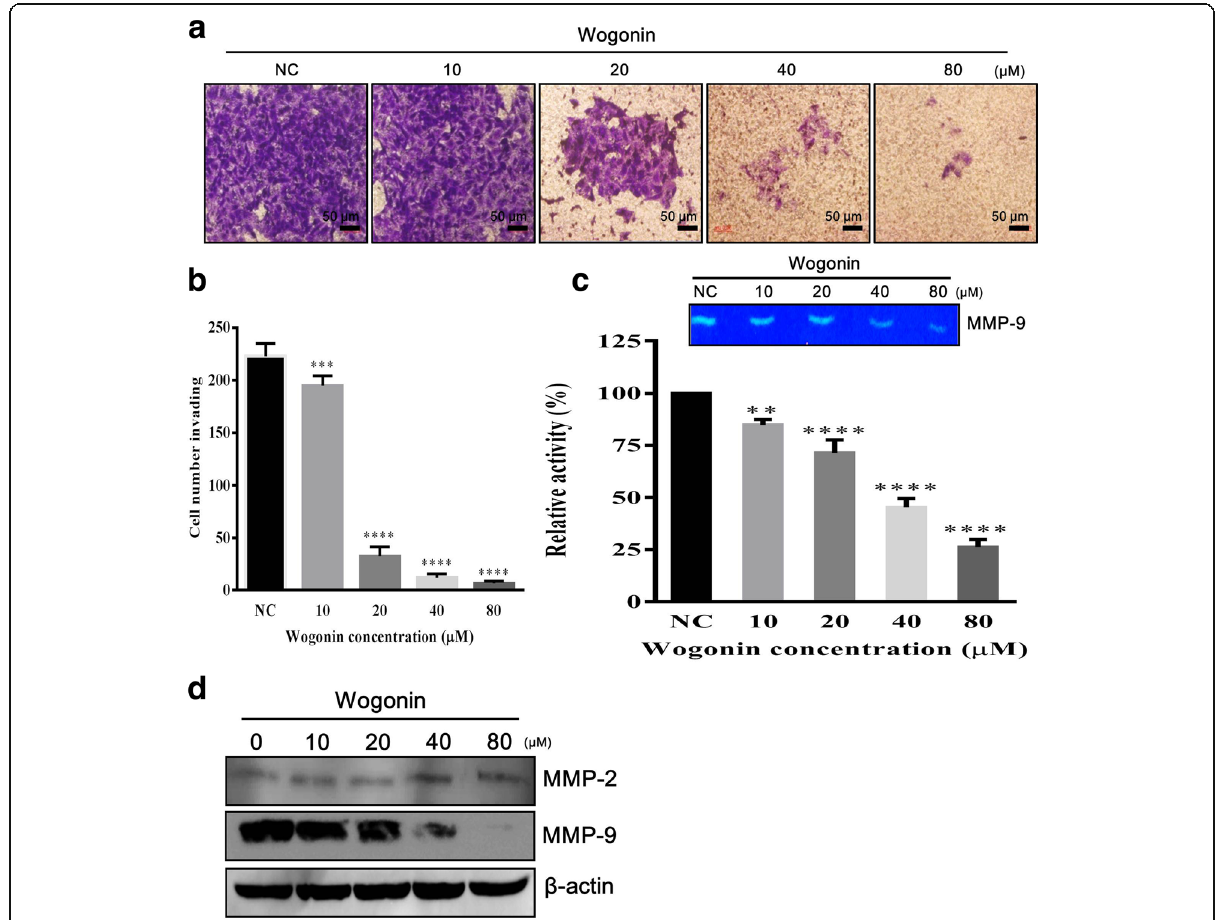
Fig. 3 Wogonin inhibits the invasion potential of CD133 + CAL72 CSC. a Cells were treated with varying concentrations of Wogonin (0, 10, 20, 40, and 80 μ M) 24 h prior to the invasion assay, followed by staining with 0.5% crystal violet. b Invading cells were calculated by counting cells in five random fields under the microscope. c Supernatant of the medium containing cultured Wogonin-treated human osteosarcoma CSC was subjected to gelatin zymography assay. d Western blot assay of total extract proteins derived from 24-h treated CSC exposed to varying concentrations of Wogonin (0, 10, 20, 40, and 80 μ M). Data are represented as mean ± SEM ( n = 3). ∗ P < 0.05, ∗∗ P < 0.01, *** P < 0.001, **** P <